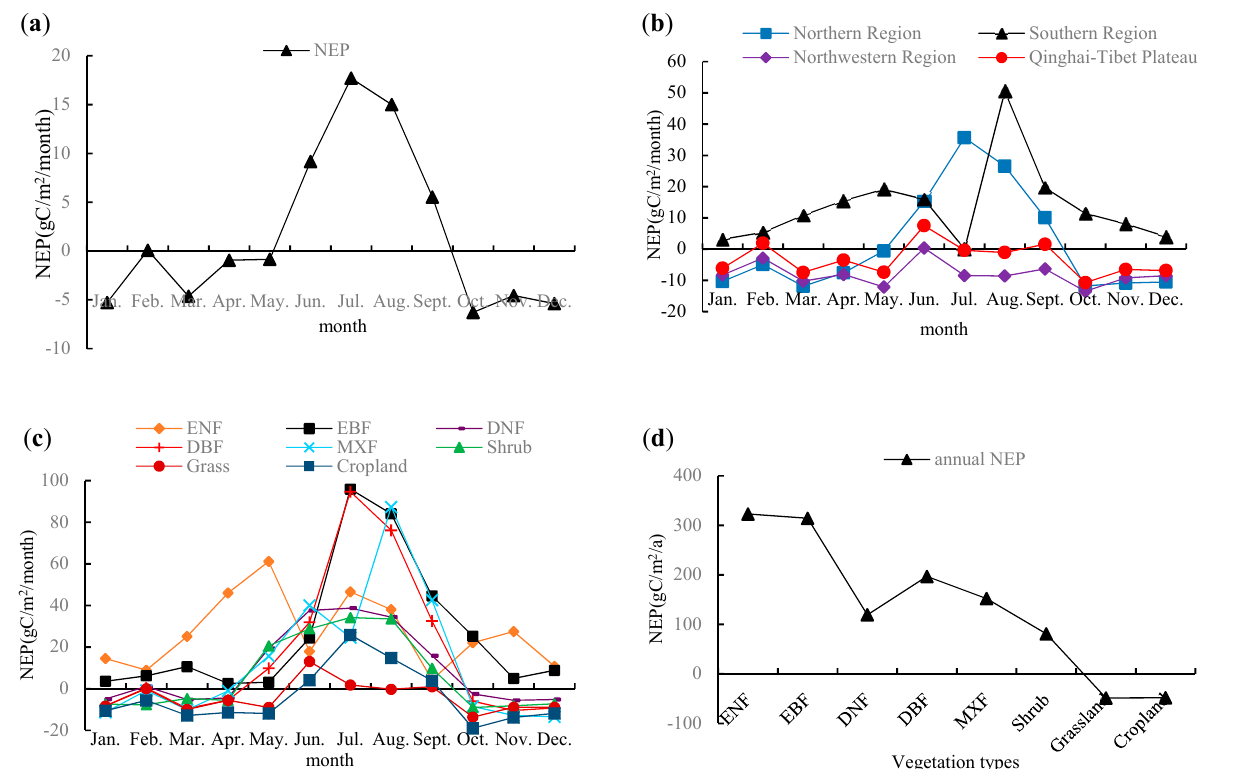
Figure 7. Annual analysis results of NEP in China. ( a ) The monthly average NEP of the whole country; ( b ) The monthly average NEP of different regions; ( c ) The monthly average NEP of each vegetation type; ( d ) Annual average NEP of each vegetation type.